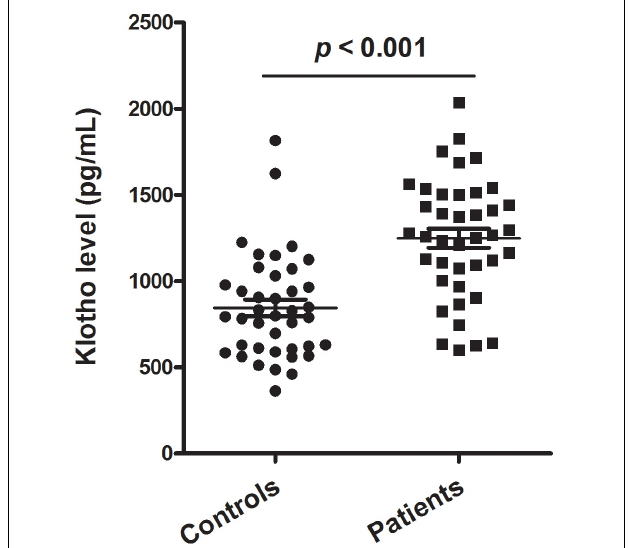
FIGURE 1 | Plasma levels of klotho in healthy controls ( n = 40) and patients with schizophrenia ( n = 40). The sample means are indicated by the black